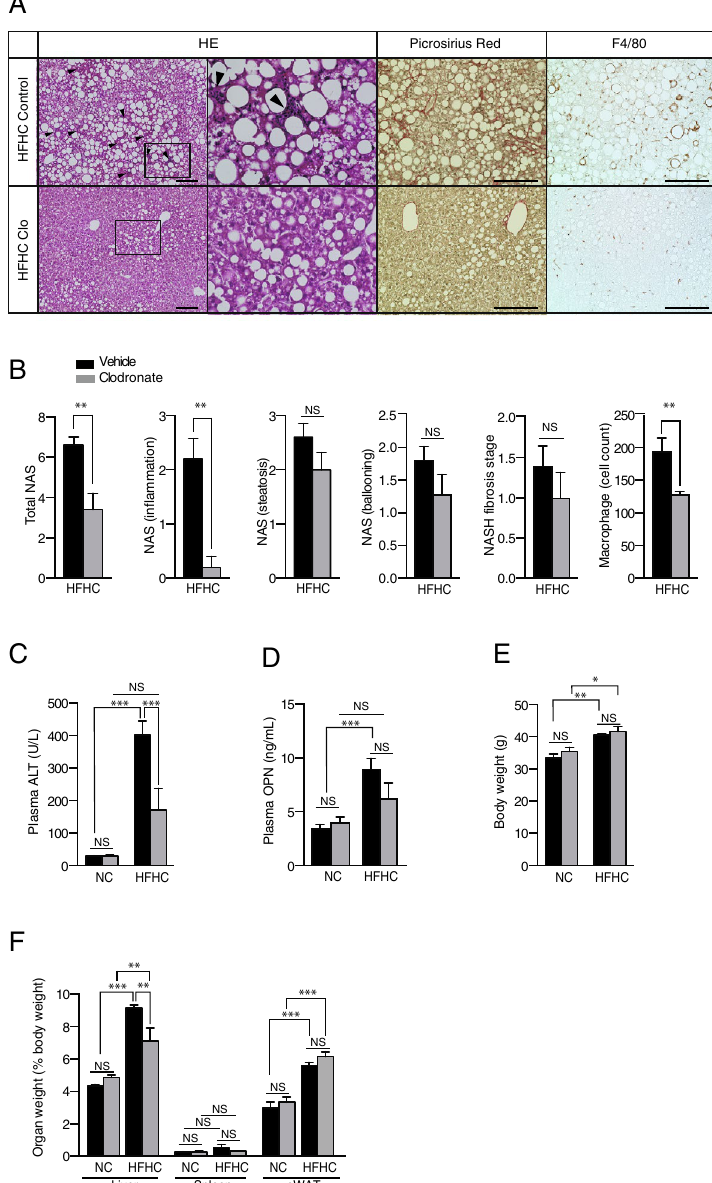
Figure 3. Oral administration of clodronate prevents high-fat, high-cholesterol diet-induced steatohepatitis. Ten-week-old C57BL/6 male mice were fed a normal chow (NC) diet or a high-fat, high-cholesterol (HFHC) diet for 24 weeks. The vehicle or clodronate was administered in the drinking water (30 mg/kg body weight/ day) for 24 weeks, n = 5 per treatment group. ( A ) Hematoxylin and eosin (HE) staining (arrowheads indicate inflammatory foci), Picrosirius Red staining, and F4/80 immunostaining of paraffin-embedded mouse liver tissue. Scale bars, 100 µm. ( B ) The total NAFLD activity score (NAS); the individual scores for lobular inflammation, steatosis, and ballooning; the NASH fibrosis stage; and the number of macrophages based on a count of the F4/80-positive cells per high-power field were quantified for the HFHC diet-fed mice. ( C ) Plasma ALT activity was determined by enzyme assay. ( D ) Plasma osteopontin (OPN) levels were quantified with an enzyme-linked immunosorbent assay. ( E ) Bodyweight, and ( F ) organ weight expressed as a percentage of the body weight, were determined at the end of the study. All data are presented as the mean ± S.E.M. * P < 0.05, ** P < 0.01, *** P < 0.001. NS not significant, ALT alanine aminotransferase, eWAT epididymal white adipose